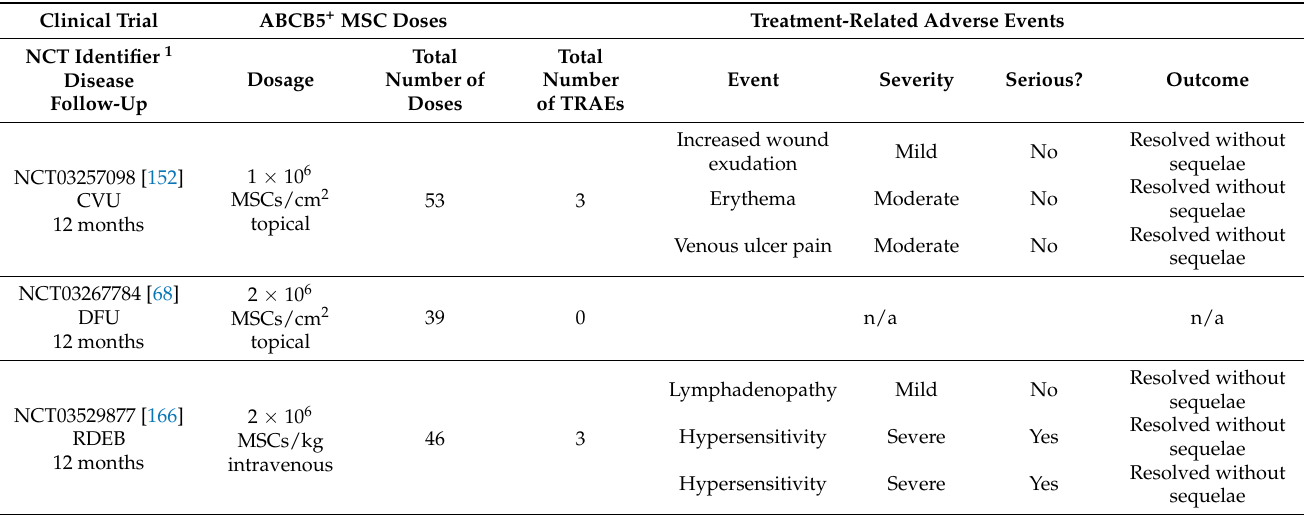
Table 3. Treatment-related adverse events reported in clinical trials of ABCB5 + MSCs. Clinical Trial ABCB5 + MSC Doses Treatment-Related Adverse